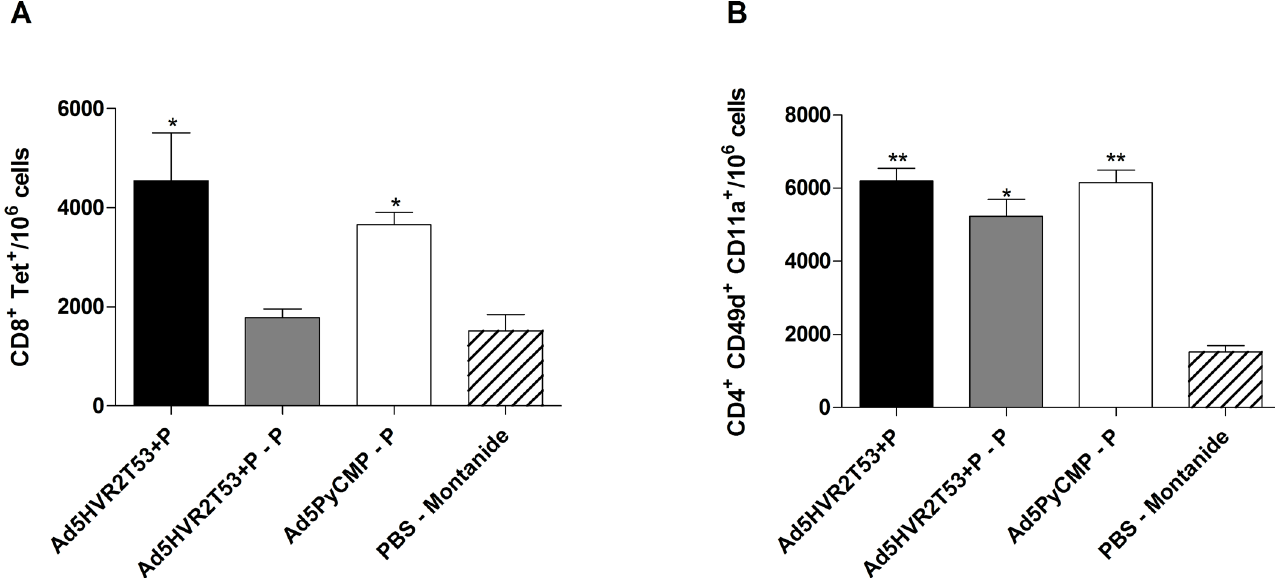
Fig 3. Cellular Responses induced by the vaccination regimens including Ad5HVR2 modified vectors. CB6F1/J (n = 10 per group) mice received the regimens described in Fig 2. PBMC derived from mice whole blood were obtained 5 days after the final immunization and were processed by flow cytometry, (A) CD8+ T cells able to recognize the P . yoelii CSP tetramer H-2K d /SYVPSAEQI. (B) CD4+ T cells expressing CD49d and CD11 as markers for the differentiation of antigen experienced cells. The results are presented as the number of cells present in 10 6 PBMC. The differences between the groups were analyzed by Kruskal-Wallis test with Dunns post-test, significant statistical differences between the groups are denoted by * (p < 0.05) ** (p < 0.01).